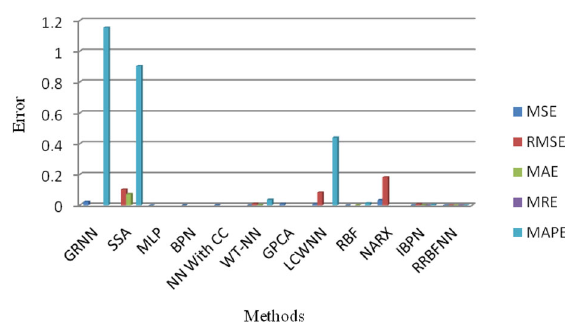
Fig. 4 Comparison of the performance